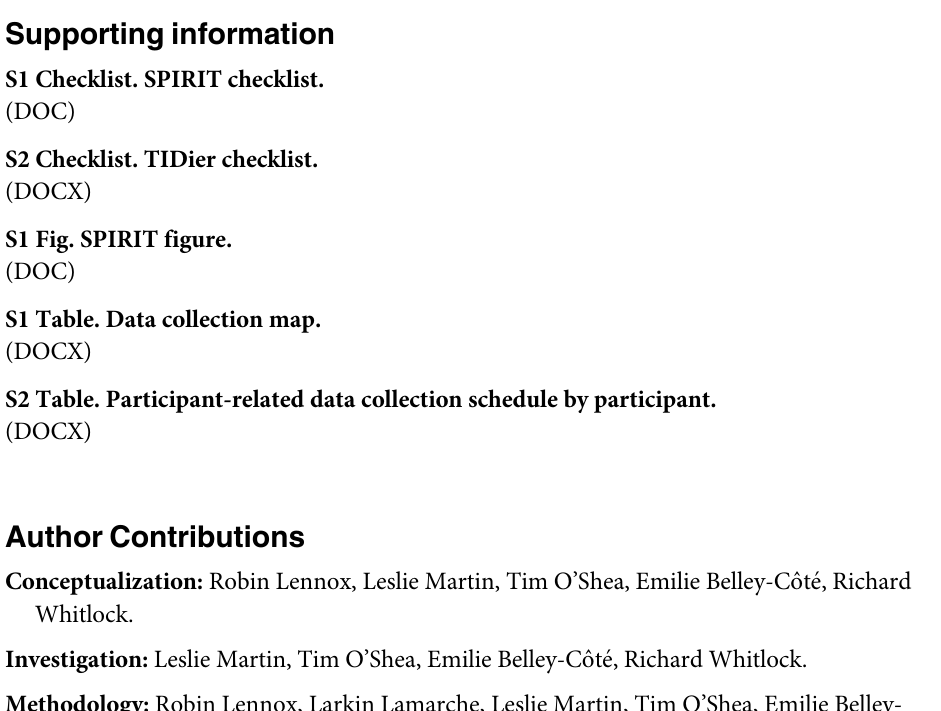
S1 Fig. SPIRIT figure. S1 Table. Data collection map. S2 Table. Participant-related data collection schedule by